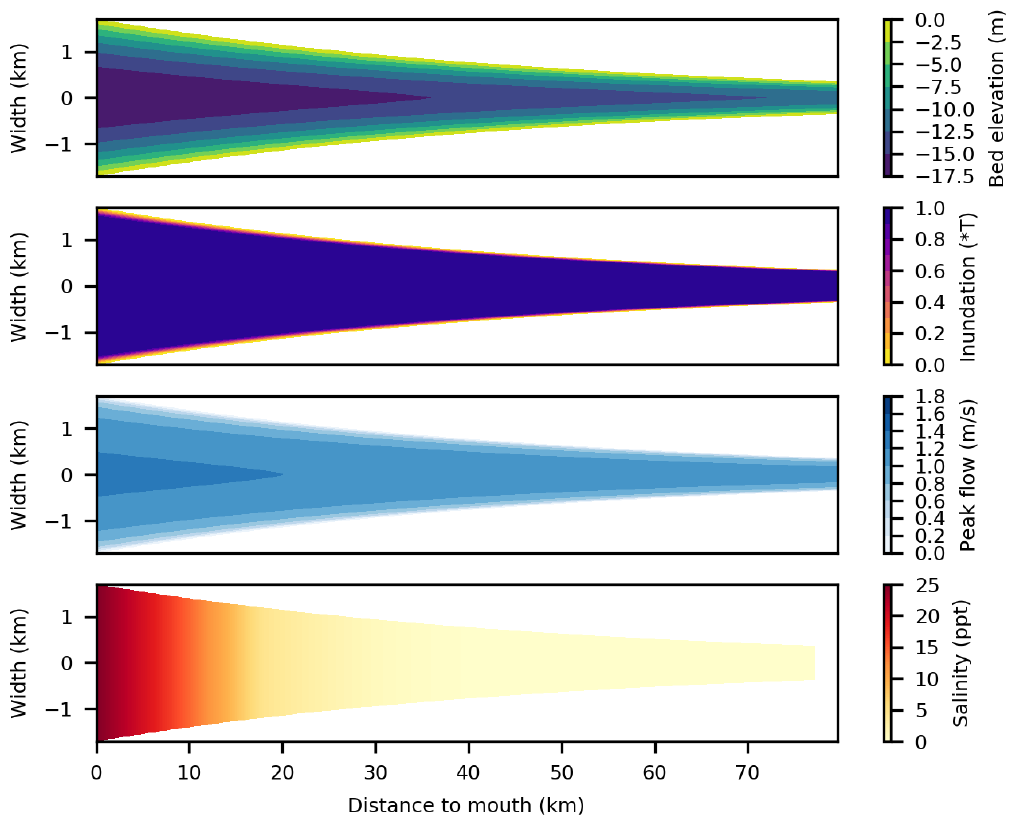
Figure 11. Resulting predictions of bed elevation with respect to the high water level, inundation duration, peak flow velocity and salinity for an ideal estuary based on dimensions of the Tran De branch of the Mekong